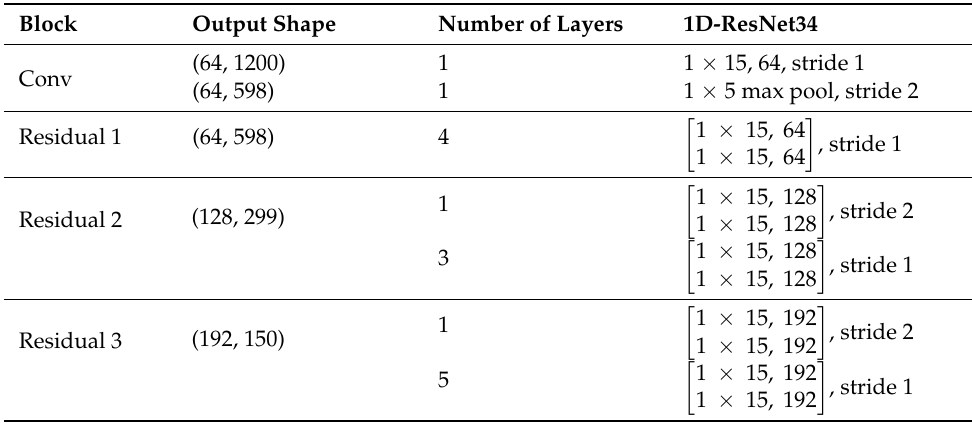
Figure 3. Modified 1D-ResNet34. ( a ) Overall architecture; ( b ) Conv block; ( c ) Residual block. Table 3. Architecture of modified